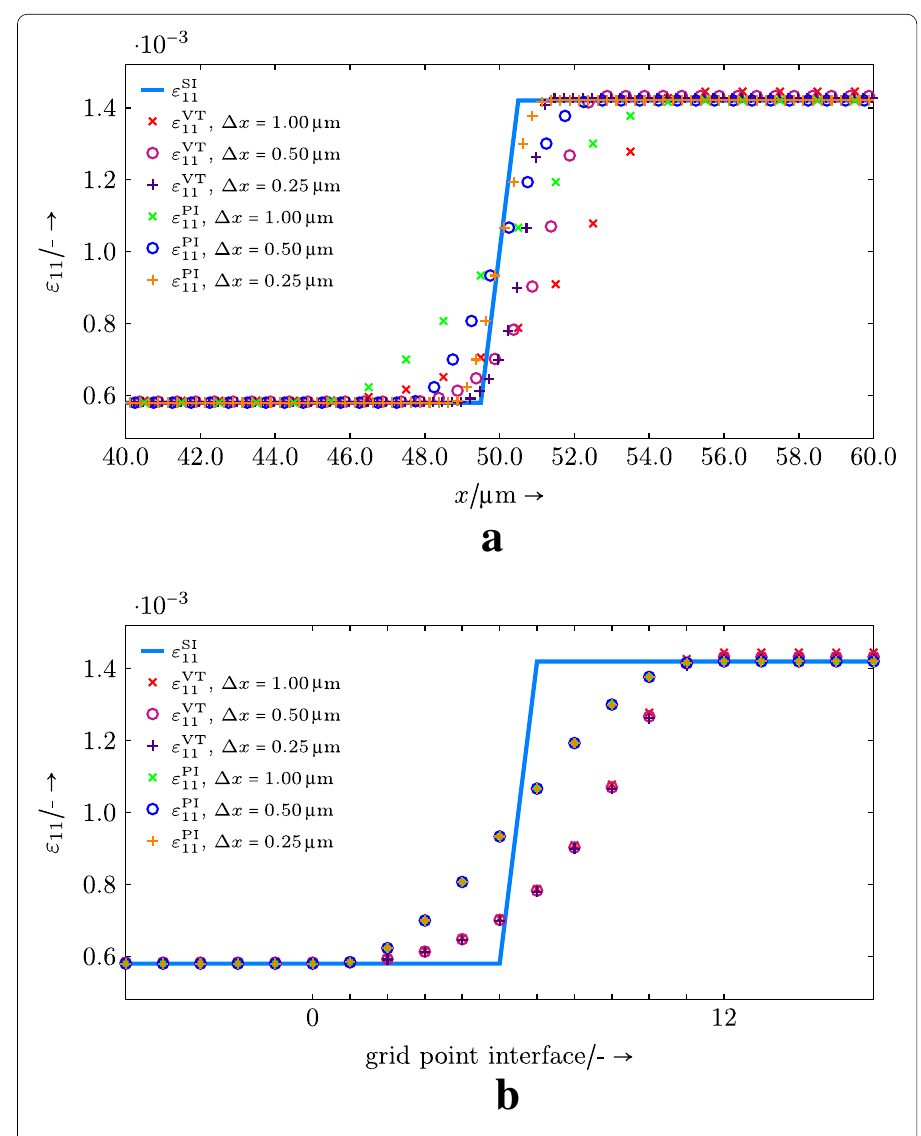
Fig. 9 Influence of different resolutions: Results for ε 11 compared to a sharp-interface solution at t = 20s. Three resolutions of (cid:14) x = { 1 . 00 , 0 . 50 , 0 . 25 } µ m are plotted along a x with y = 49 . 5 µ m and b the grid points in the interface (i.e. the interface is entered from the left at interface grid point 0 and left towards the right at interface grid point